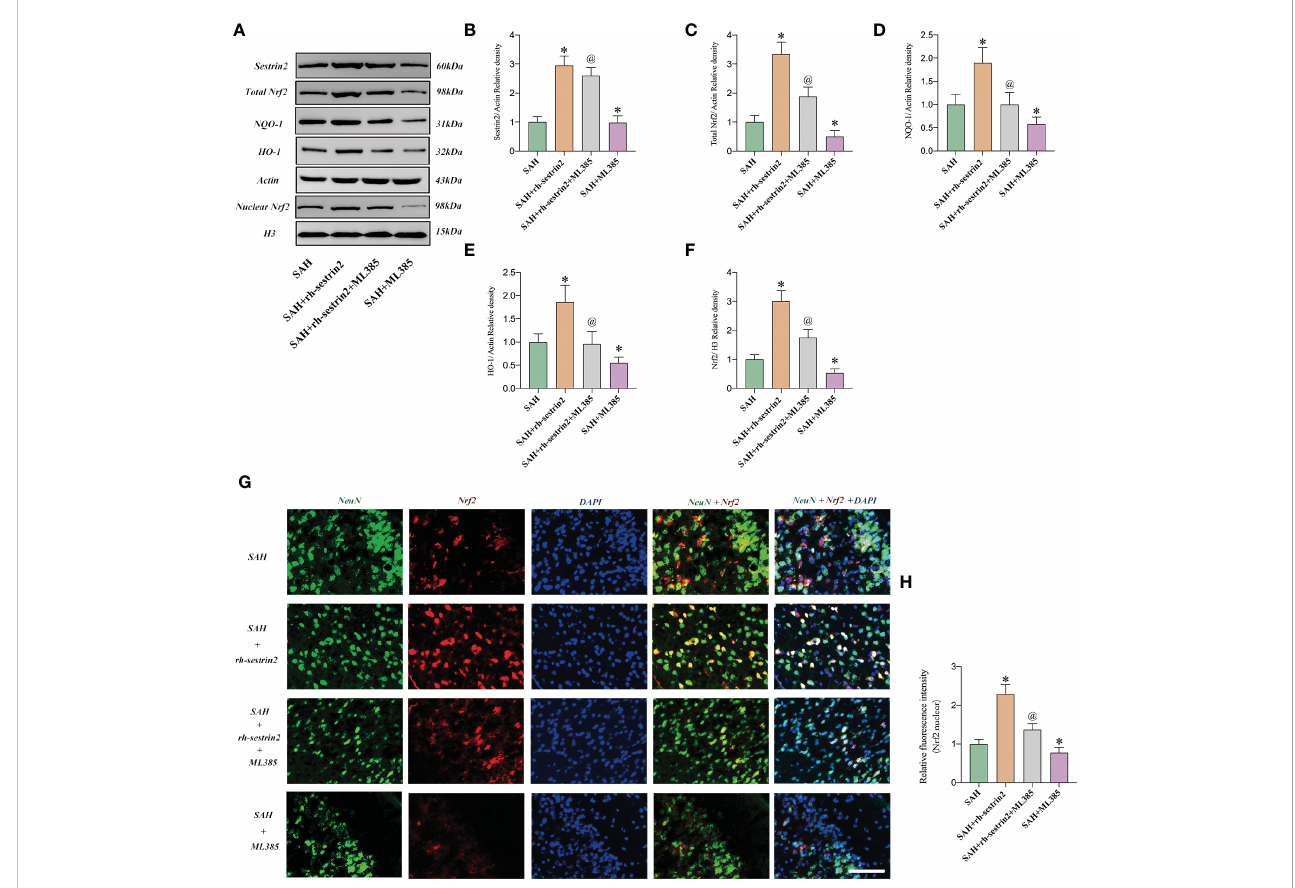
FIGURE 4 Rh-sestrin2 treatemtn induced Nrf2 signaling activation after SAH. (A) Representative western blot bands and quantitative analysis of (B) sestrin2, (C) total Nrf2, (D) NQO-1, (E) HO-1, and (F) nuclear Nrf2 in different groups (n = 6 per group). (G) Representative images and (H) quanti fi cations of Nrf2 staining in different groups (n = 6 per group). * P < 0.05 versus sham group. @ P < 0.05 versus SAH group. Data indicated as mean ± SD. Scale bars = 50 m